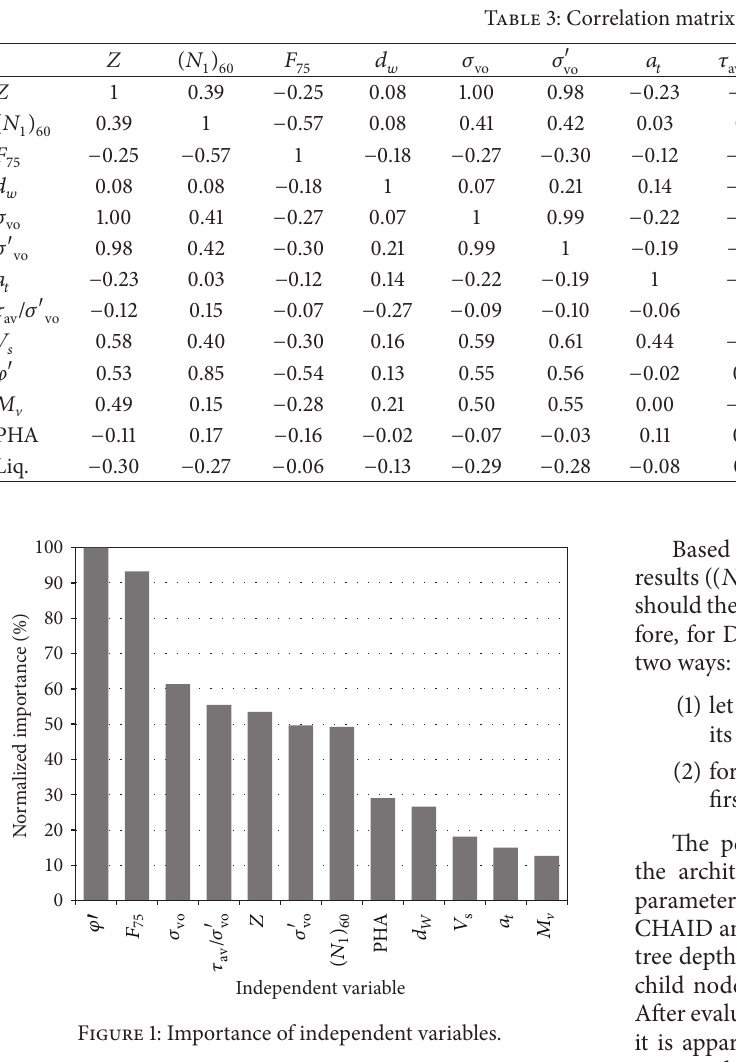
the CHAID and E-CHAID algorithms, and again serves as the first